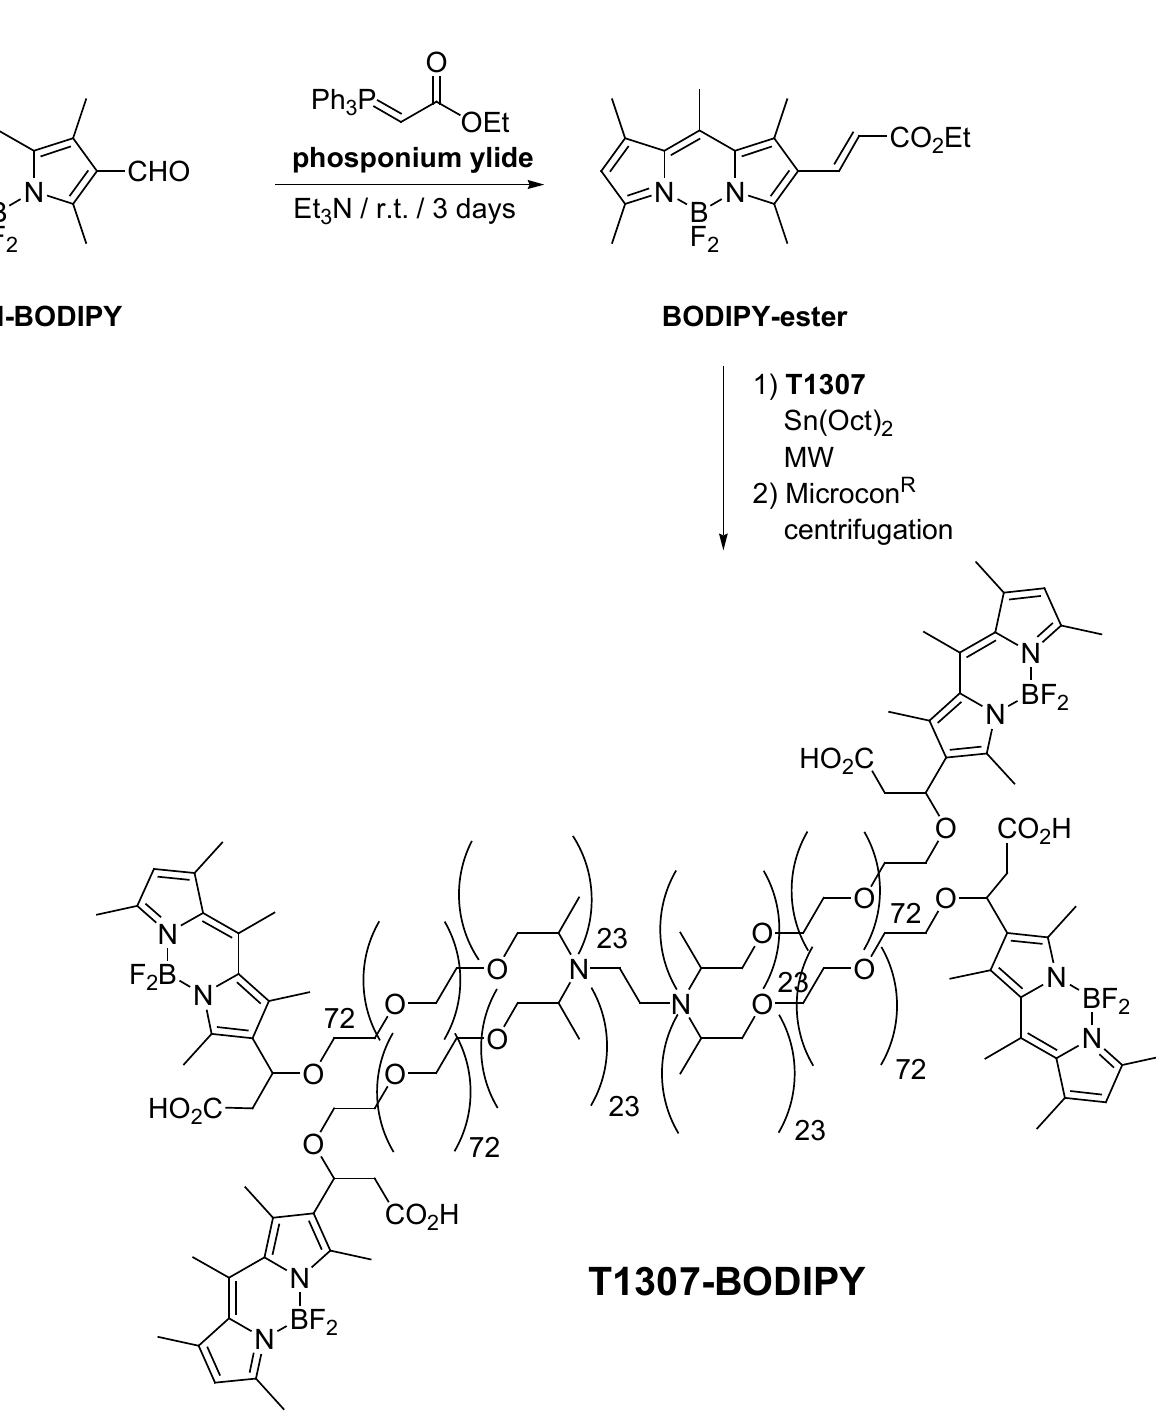
FIGURE 1 – Synthetic procedure for T1307-BODIPY obtention. Synthesis of the T1307-BODIPY (Glisoni, Sosnik,